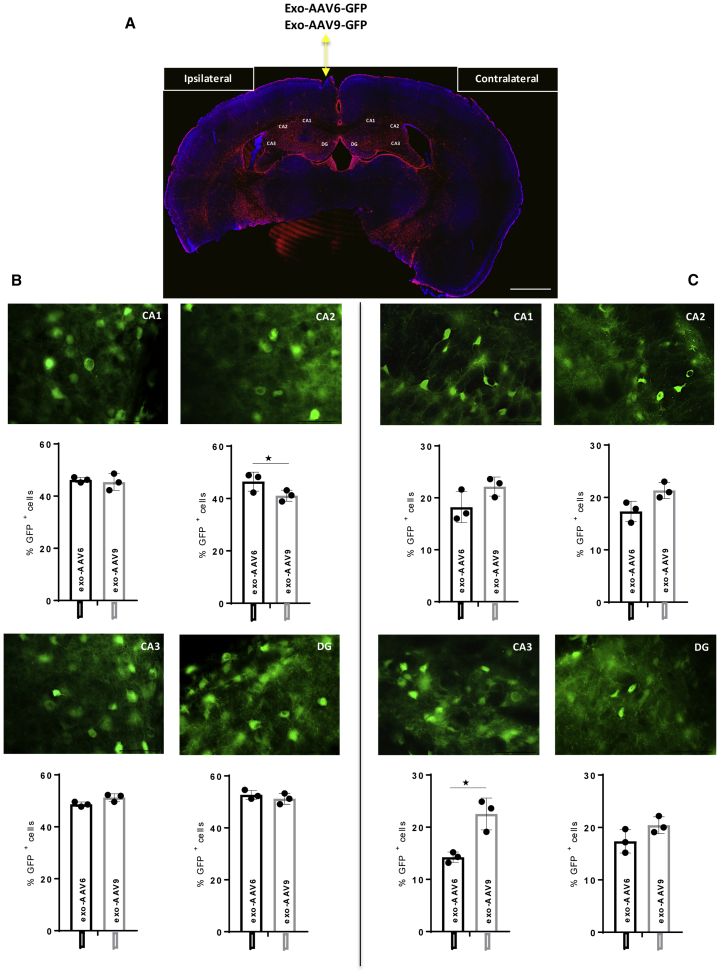
Quantification of exo-AAV6-9-Mediated GFP-Positive Cells in the Contralateral Hippocampus(A) Representative coronal brain section showing GFP distribution after unilateral injection of exo-AAV6-9 vectors (2 μL) into the ipsilateral hemisphere and PBS (2 μL) into the contralateral hemisphere of C57BL/6 mice. Images were captured by a Leica SP8 confocal microscope at 10× magnification. Scale bar 1 mm. (B) Quantification of GFP-positive cells visible enumerated in Cornu Ammonis subfields (CA1, CA2, and CA3) and in dentate gyrus (DG) in the ipsilateral hemisphere. CA2 (n = 3; p = 0.0319). (C) Quantification of GFP-positive cells visible enumerated in CA1, CA2, and CA3 and in DG in the contralateral hemisphere. CA3 (n = 3; p = 0.0397). Data were analyzed by an unpaired Student’s t with Mann-Whitney test and are expressed as percentages of GFP+ cells. Results were considered statistically significant with *p < 0.05 and levels of significance are indicated as follows: *p < 0.05. Data are presented as mean ± SEM. Images were by Leica DM6000 B fluorescence at 63× magnification. Scale bar 50 μm.